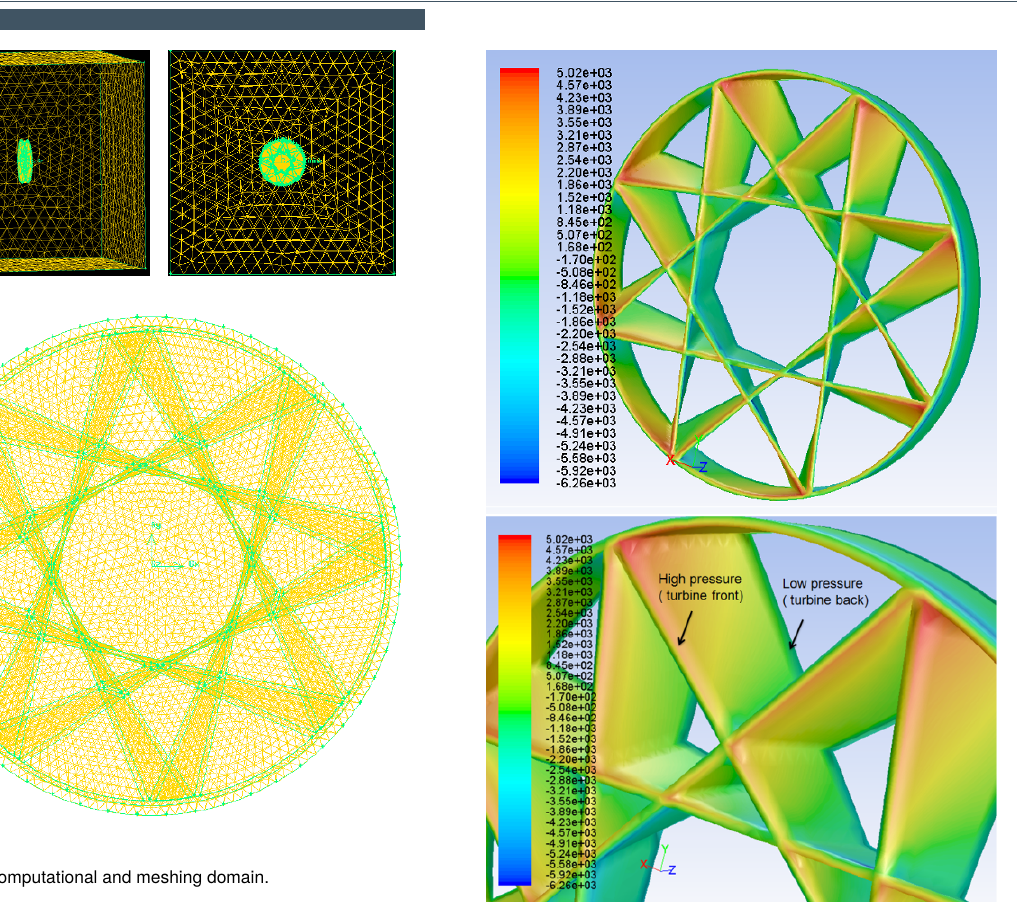
Figure 3. Computational and meshing domain.